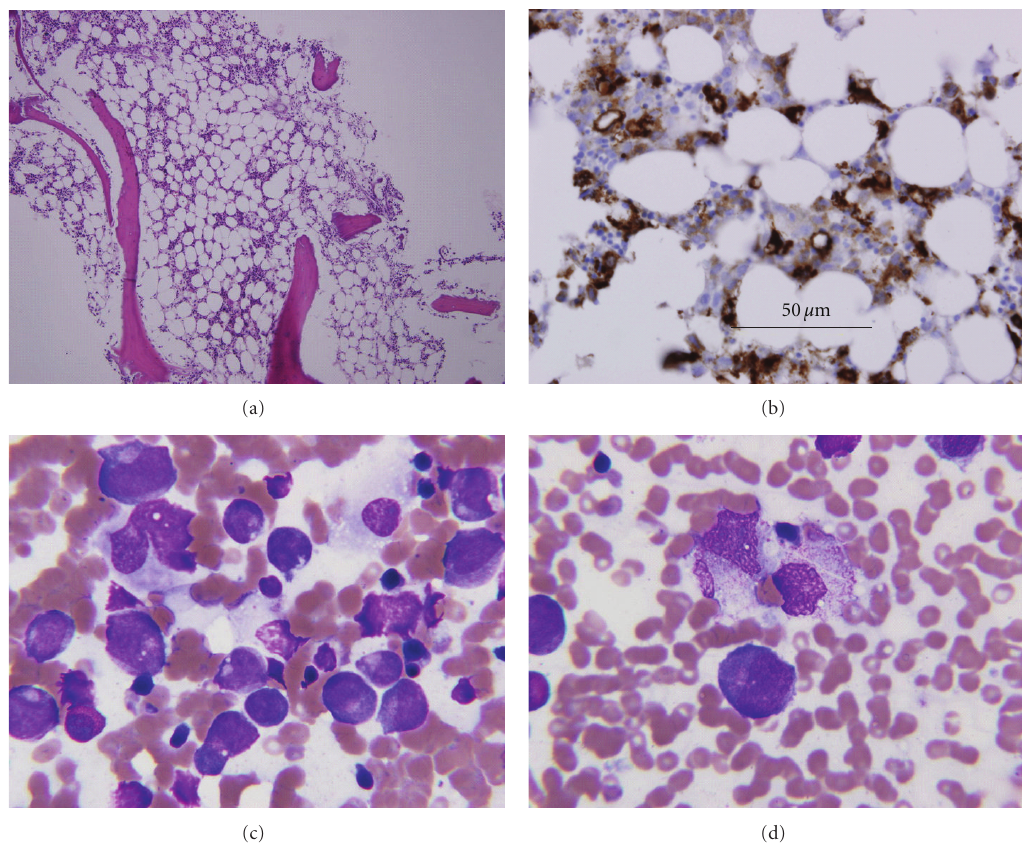
Figure 2: Bone marrow study: (a) mild hypocellularity. (b) Positive histiocytes stain for CD68 marker. (c) Myeloid cell line composed mostly of promyelocytes with prominent Golgi apparatus and absent neutrophils and metamyelocytes (maturation arrest). (d) Histiocytes and promyelocyte (center) with a rare histiocyte showing